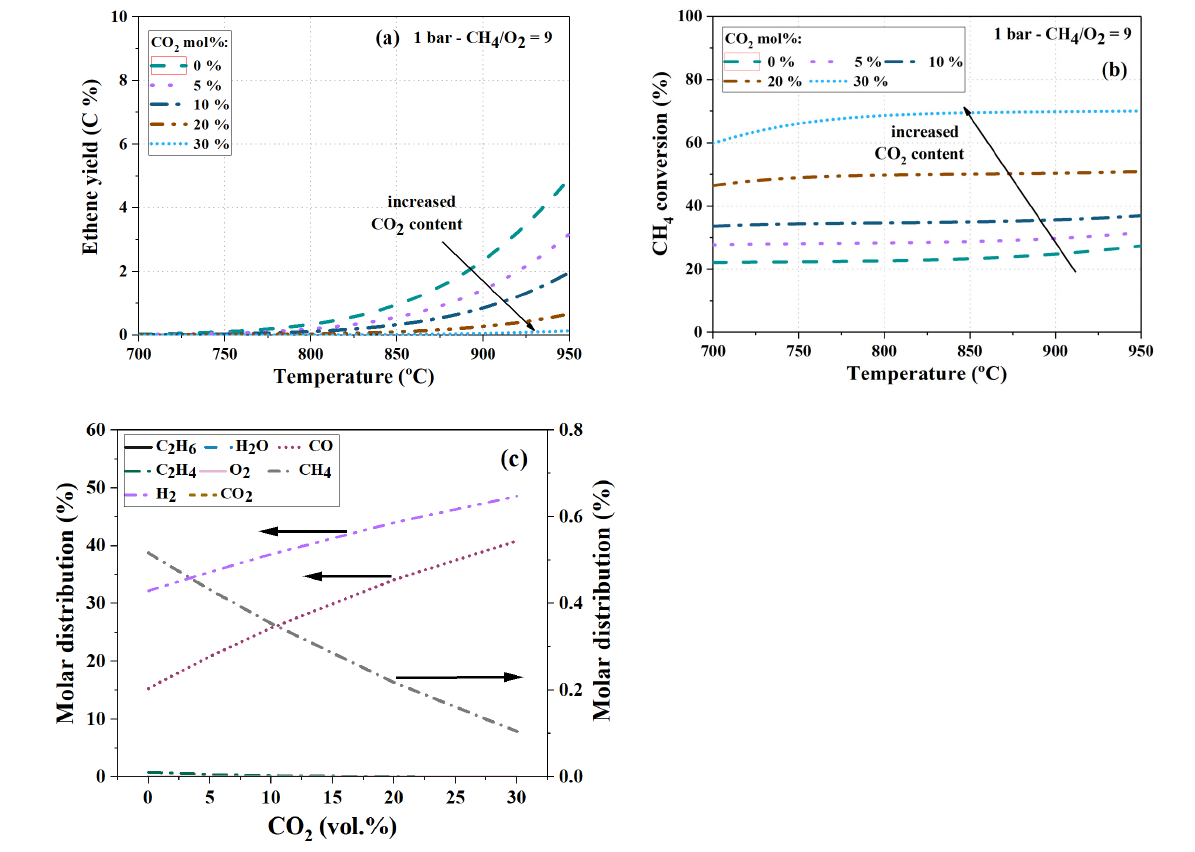
Figure 26. Effect of co-feeding CO 2 on carbon-based ethene yield ( a ) and CH 4 conversion ( b ) as a function of temperature at the CH 4 /O 2 molar feed ratio equal to 9 and pressure of 1 bar; and ( c ) equilibrium molar distribution as a function of CO 2 feed composition at 900 ◦ C, 1 bar and CH 4 /O 2 molar feed ratio equal to 9. CO 2 composition in the feed was varied while keeping the total number of mols and the CH 4 /O 2 feed molar ratio constant. Ethene yield was calculated considering both methane and CO 2 in the feed.